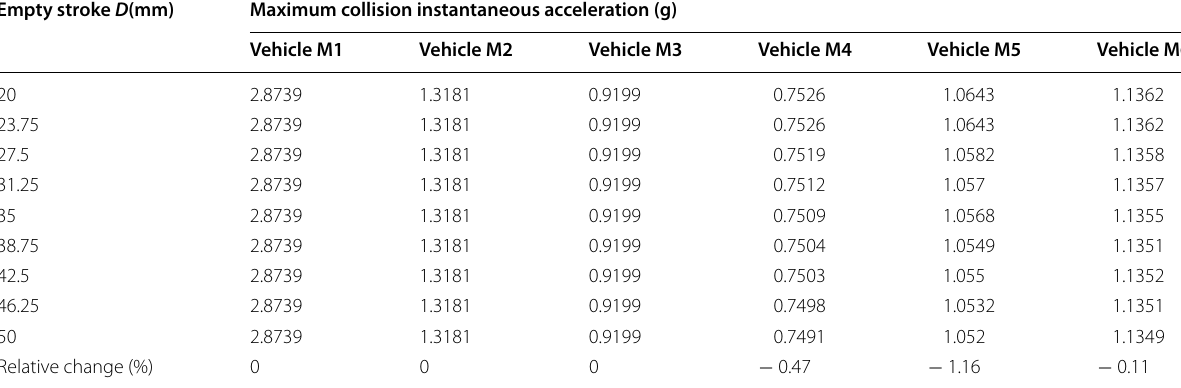
Table 4 Vehicle collision acceleration response under different D Empty stroke D